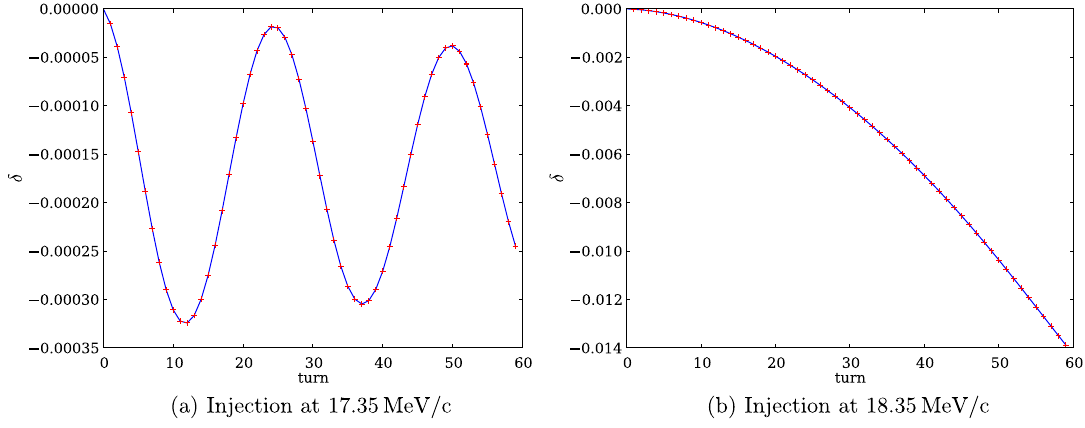
12. Simulated effects of beam loading upon particle